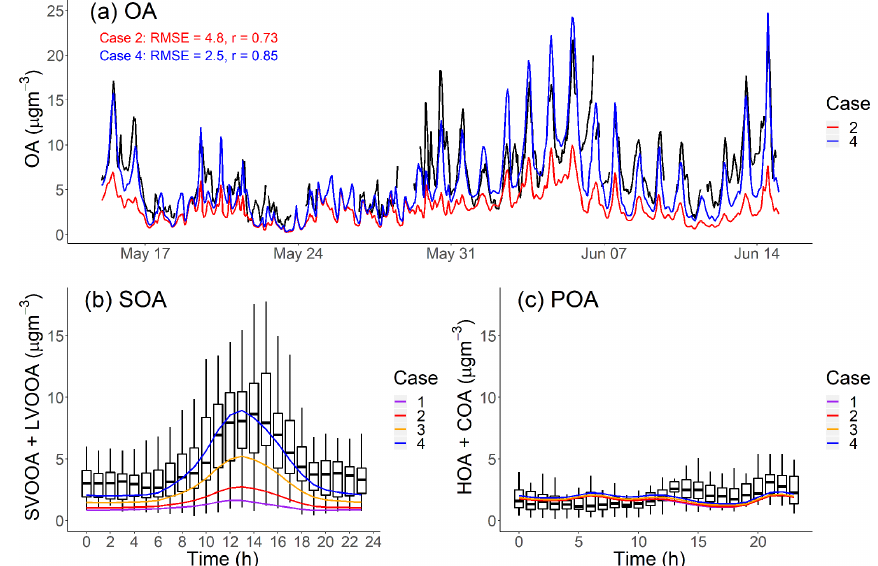
Figure 5. (a) PM 1 -OA component hourly-averaged time series of measured data and model output in Pasadena, CA, during the CalNex campaign. (b, c) Diurnal pattern of measured and modeled SOA and POA mass concentration in Pasadena, CA, during CalNex. Measured data from Hayes et al. (2013).